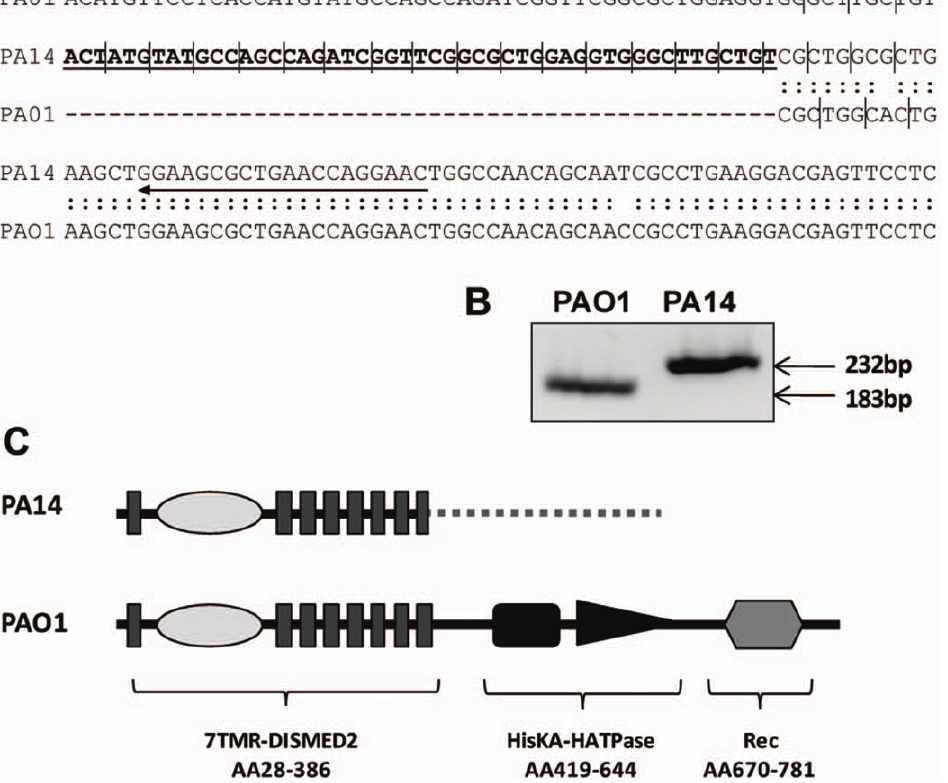
Figure 1. PA14 is a ladS mutant. (A) Alignment of the ladS open reading frame of PAO1 and PA14 starting at + 1021 bp. The bold underlined sequence in PA14 shows the 49 bp duplication, which alters the PA14 reading frame compared to PAO1, illustrated by vertical lines. PCR primers are indicated by arrows. (B) PCR products of the genomic region indicated in (A), separated by agarose gel electrophoresis. (C) Predicted domain organization of LadS in PA14 and PAO1. Nonsense protein sequence in PA14 is shown with a dotted line.